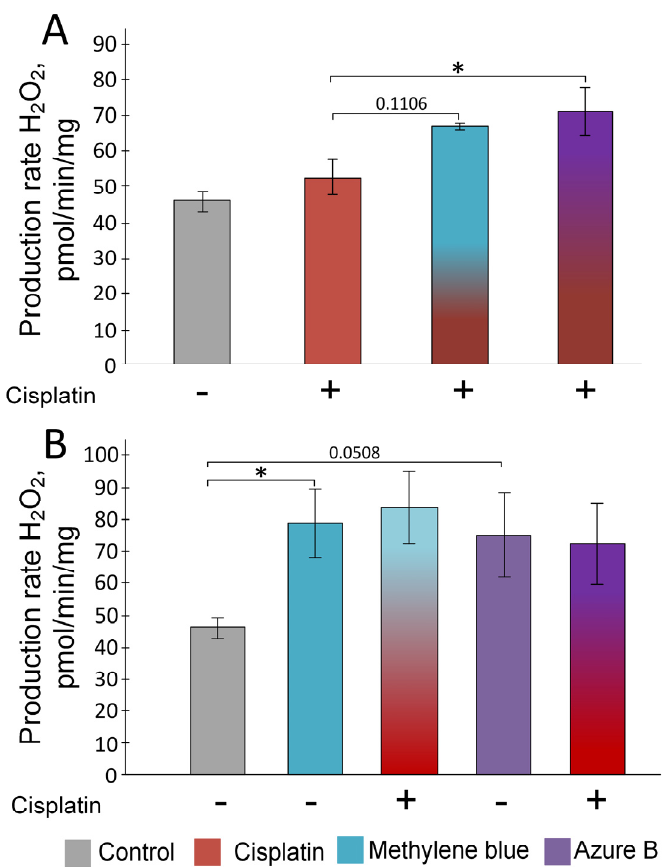
Figure 1. Impact of cisplatin, methylene blue, and azure B on the rate of H 2 O 2 production: ( A ) Addition of cisplatin did not increase the rate of H 2 O 2 production, and subsequent additions of methylene blue or azure B increased it; ( B ) Addition of methylene blue or azure B increased the rate of H 2 O 2 production, and subsequent additions of cisplatin did not impact on the rate of H 2 O 2 production. The results are expressed as means ± SEM. * Differences are statistically significant p < 0.05 (Mann–Whitney test). All measurements were provided in at least four repetitions.